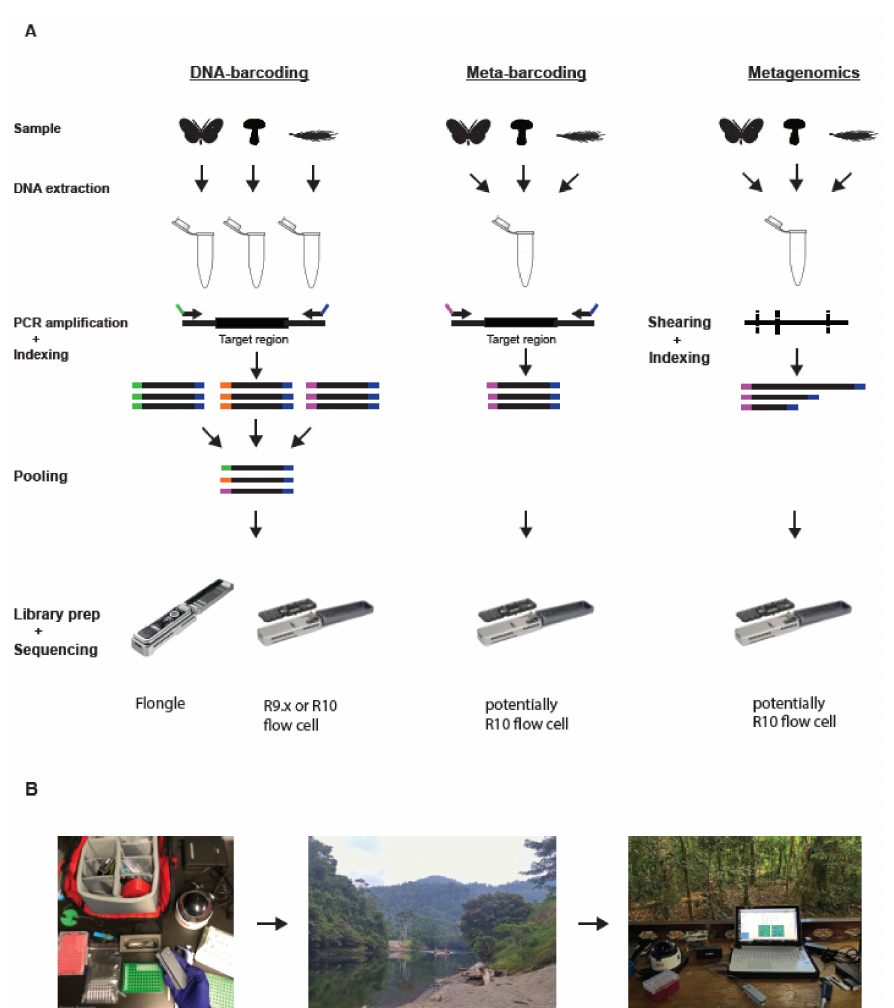
Figure 1. ( A ) Schematic of di ff erent genetic biomonitoring approaches using the MinION platform. ( B ) Schematic of the application of the mobile sequencing laboratory. ( A ) Left panel: DNA barcoding involves extracting DNA and performing PCR amplification from individual specimens. Amplicons